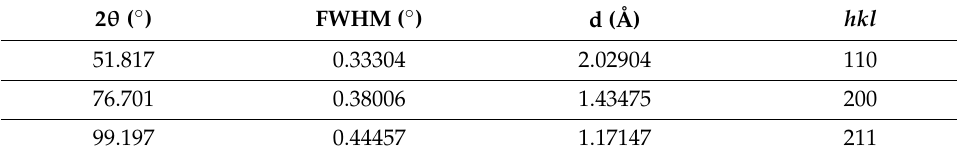
Figure 2. X-ray diffraction pattern of the AR sample. Table 2. Parameters obtained from the XRD analysis in the sample AR.